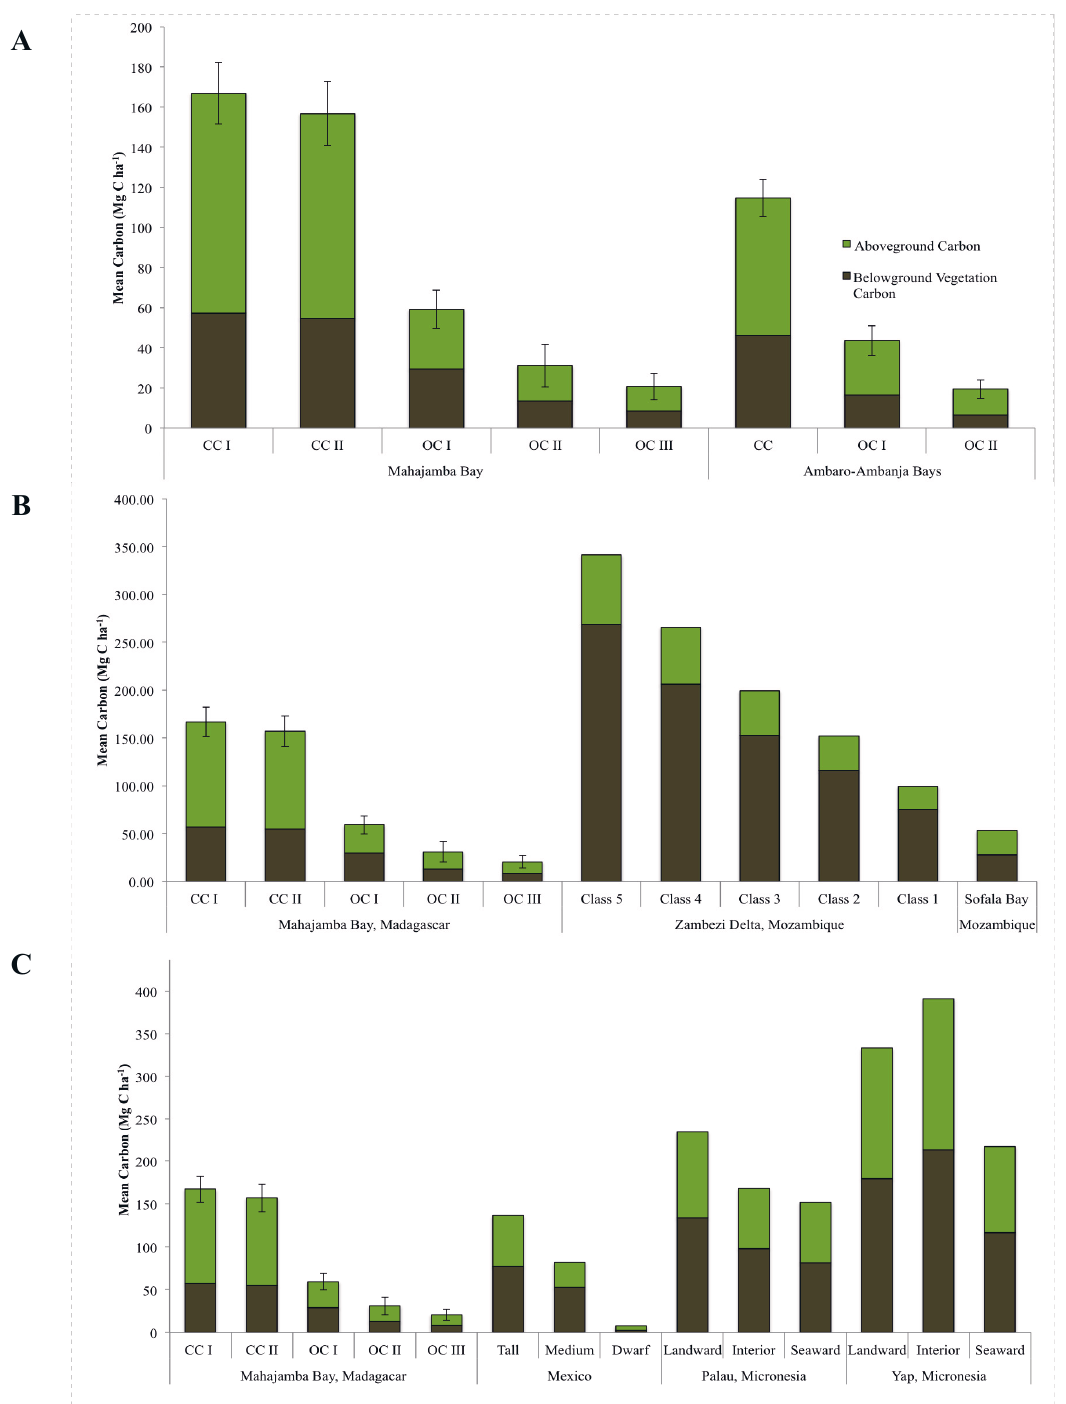
Figure 9. Vegetation carbon stock estimations for Mahajamba Bay, Madagascar compared with other published carbon stocks ( A ) within Madagascar: Ambaro-Ambanja Bays (adapted from [100], with permission from © 2015 Springer); ( B ) within the Western Indian Ocean: Zambezi Delta (adapted from [101], with permission from © 2014 USFS) and Sofala Bay (adapted from [37], with permission from © 2014 MDPI); and ( C ) across the globe: Mexico (adapted from [102], with permission from © 2011 Public Library of Sciene), and two regions in Micronesia: Palau and Yap adapted from [87], with permission from © 2011 Springer). Error bars on Mahajamba data indicate ±